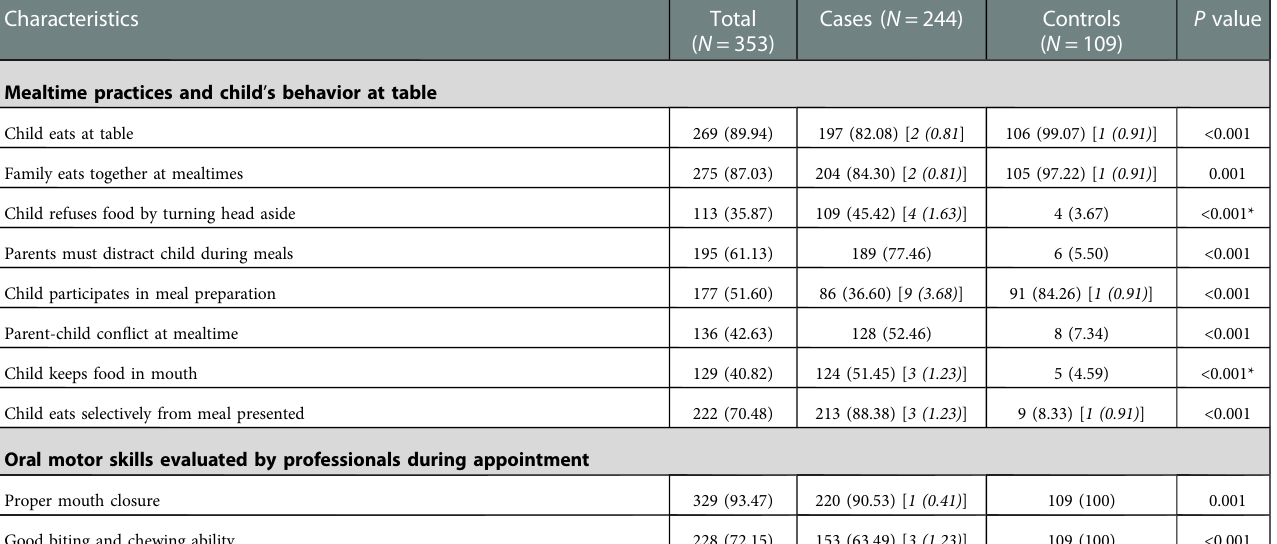
TABLE 2 Mealtime practices, oral motor skills, and psychomotor development. Data represents number (%) of patients with stated characteristics. Where there are missing data, the number (%) of children concerned is indicated in italics and brackets.